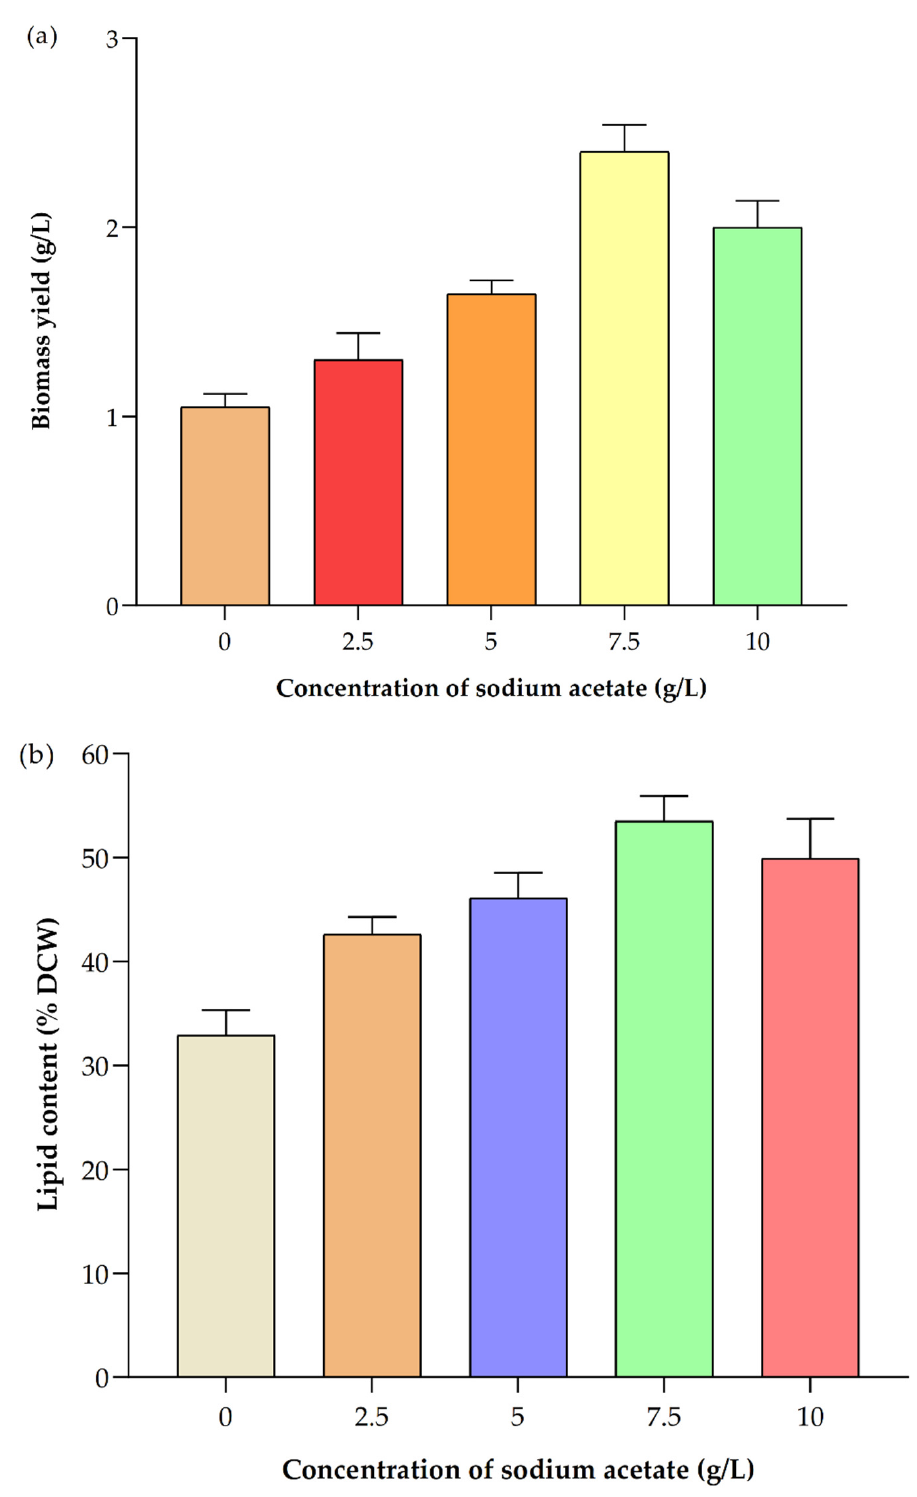
Figure 6. Impact of different concentrations of sodium acetate on Picochlorum sp. BDUG 100241 under mixotrophic conditions: ( a ) biomass production and ( b ) lipid content.